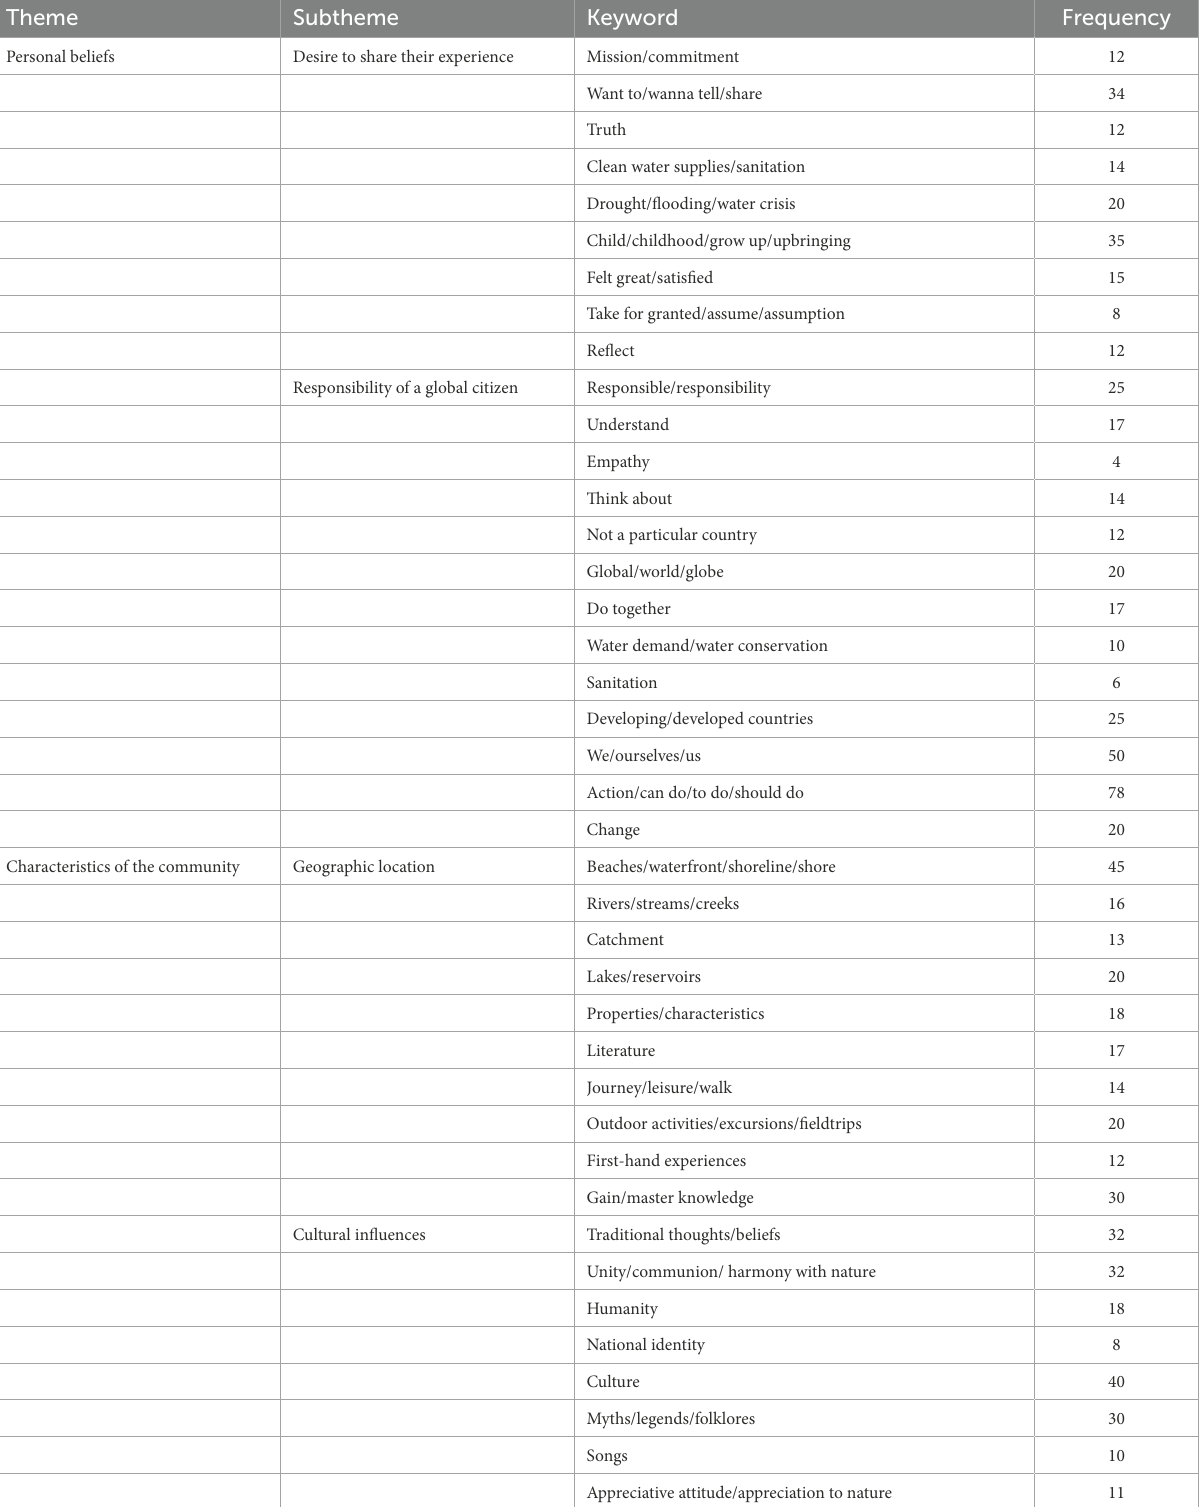
TABLE 3 Keyword chart of the themes and